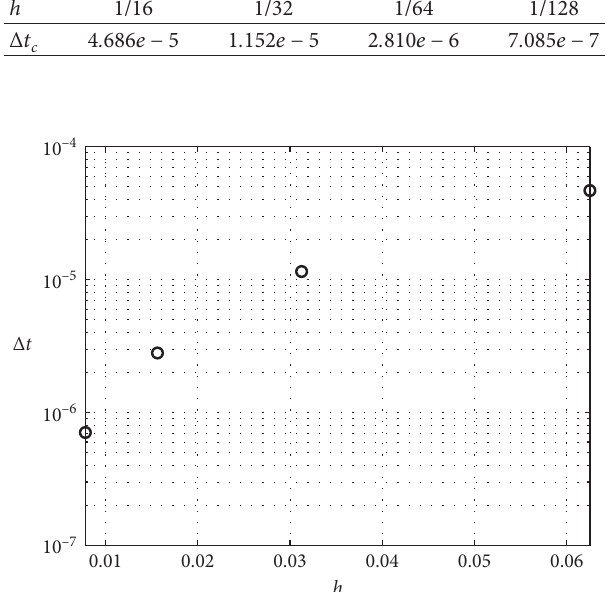
Table 2: Practical maximum time step size Δ t